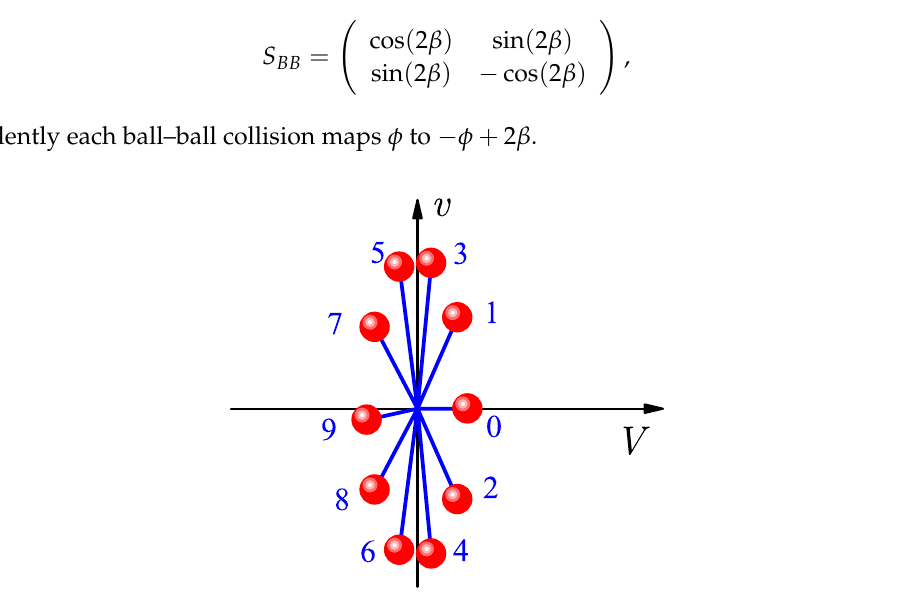
Figure 3. A characteristic example of the dependence of the vector of velocities v = ( V , v ) on collision number n . The shown data is obtained for b = 3 and N = 1 and is an example where Π = 9 and the last collision is ball–ball. The vector of velocities form an ellipse.